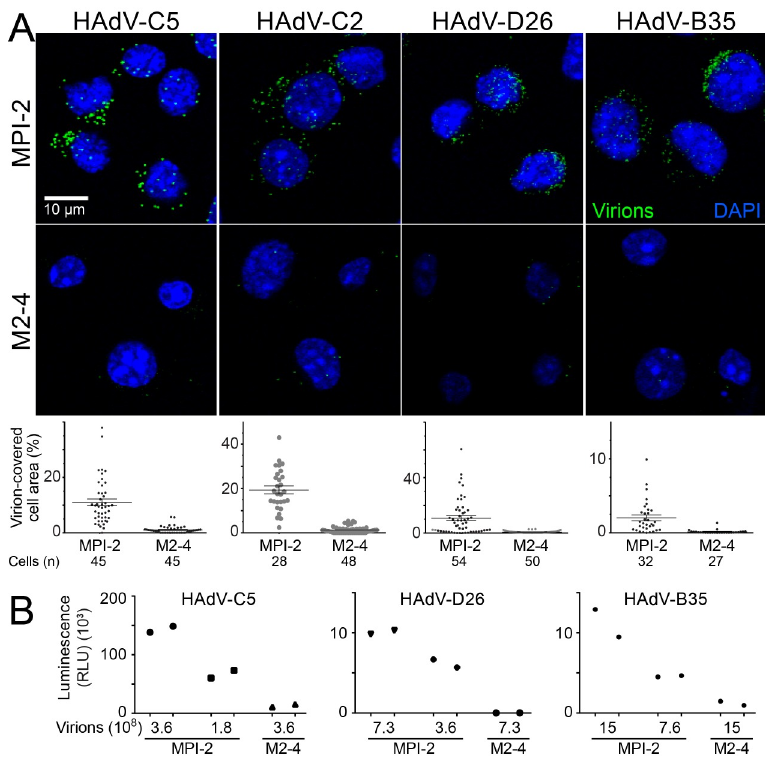
Fig 5. SR-A6 facilitates binding of HAdV-C2, HAdV-D26 and HAdV-B35 to MPI-2 cells. A) Alexa- Fluor488-labeled virus particles were added to wild type MP1-2 or to the SR-A6 knockout M2-4 cells as described in the legend to Fig 2A. Images shown are maximum projections of confocal stacks. Virus particles are pseudo-colored green and nuclei (DAPI) blue. Scale bar = 10 μ m. The plots show quantification of virus binding efficiency, expressed as percentage of cell area covered by virus particles. Error bars represent the means ± SEMs, and number of cells analyzed is indicated. The difference in virus binding to MPI-2 and M2-4 cells was statistically significant for all viruses (P < 0.0001, Kolmogorov-Smirnov test). B) SR-A6 facilitates HAdV-D26 and HAdV-B35 virus transduction. Wild type MPI-2 and the SR-A6 knockout M2-4 cells (~8 × 10 4 ) were infected with indicated amounts of recombinant virus vectors carrying the Firefly luciferase gene, and the luciferase enzyme activity in cell extracts was used to estimate the virus transduction efficiencies at 20.5 h pi. The plot shows results from two technical replicates.